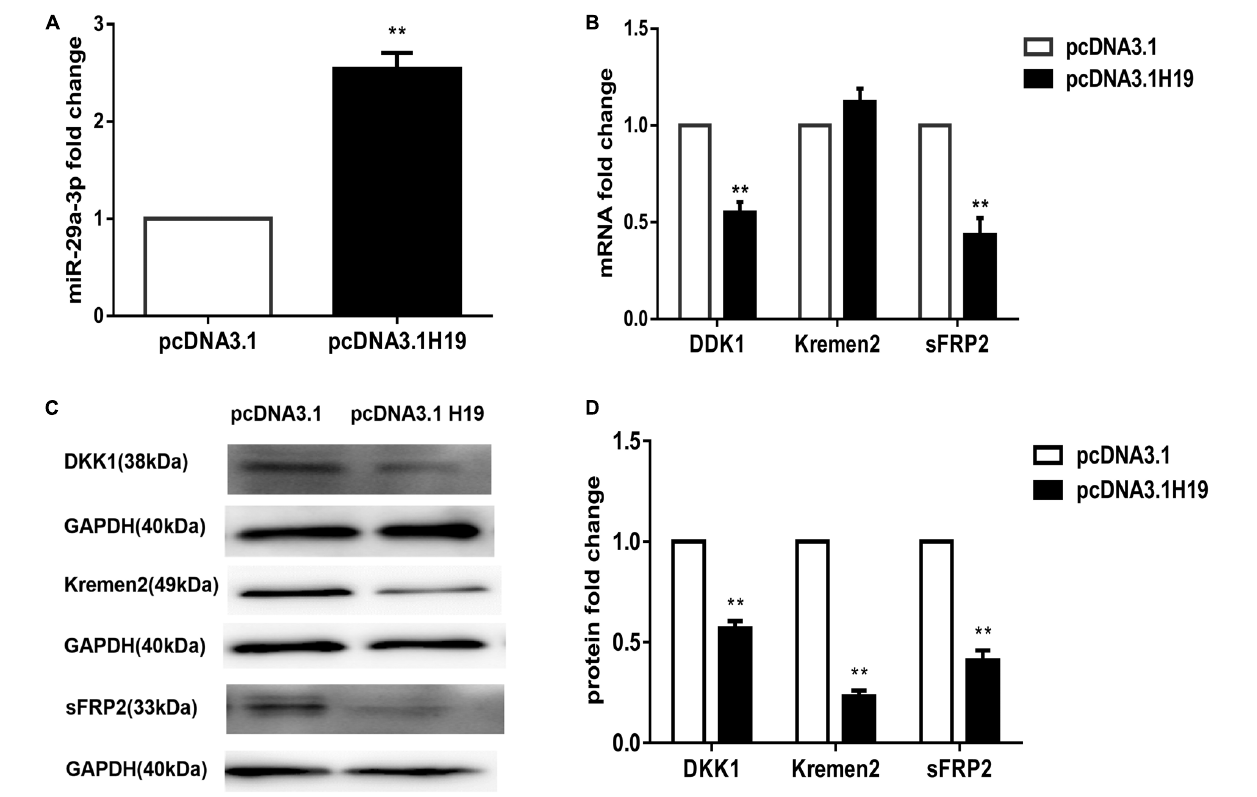
FIGURE 2 | LncRNAH19 overexpression activates Wnt signaling by upregulating miR-29a-3p in DP4 cells in vitro . (A) LncRNAH19 overexpression upregulated the level of miR-29a-3p. (B) QPCR showed that DKK1 and sFRP2 were down-regulated, but Kremen2 mRNA expression was slightly increased when H19 was overexpressed in DP cells. (C) LncRNAH19 overexpression decreased Dkk1, Kremen2, and sFRP2 protein levels compared with the mock-vehicle group. (D) Quantification of Dkk1, Kremen2, and sFRP2 protein expression levels. Data shown represent the mean ± SEM of three independent experiments. ** P <